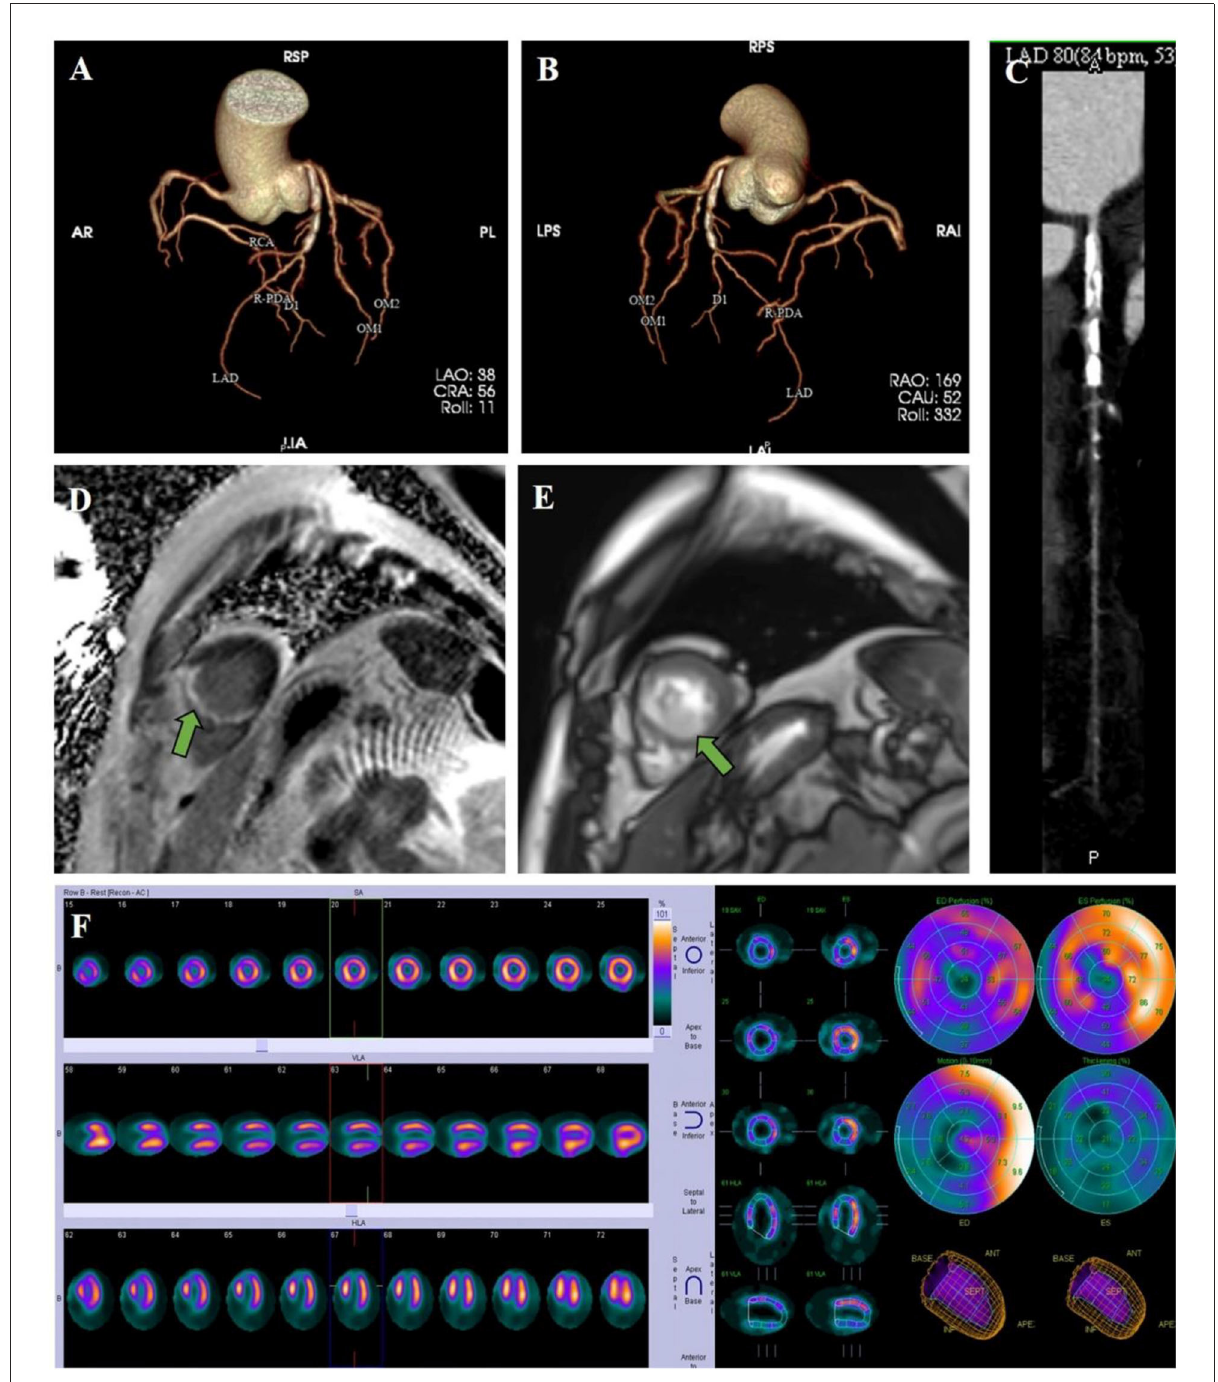
FIGURE3 Clinical imaging. (A–C) A coronary CT scan showed that the proximal anterior descending artery had severe calcification and stenosis. (D) Cardiac magnetic resonance imaging revealed delayed enhancement on the apical septal and inferior walls, which presented transmural MI. (E) Cardiac magnetic resonance imaging confirmed the presence of a thrombus at the apex. (F) Resting myocardial radionuclides showed transmural MI and blood perfusion decrement.